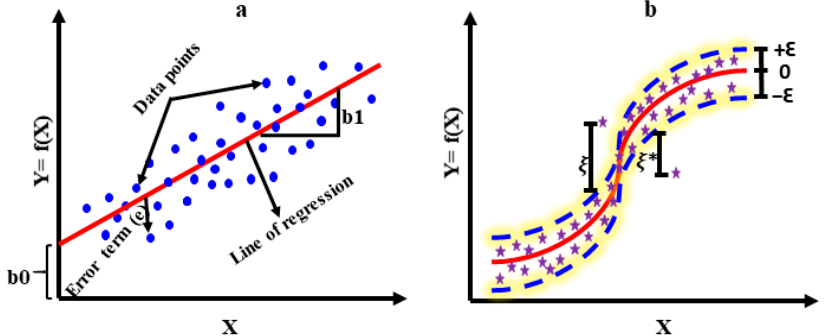
Figure 4. Diagrams indicating the structure of ( a ) linear regression (LR) and ( b ) support vector regression (SVR).